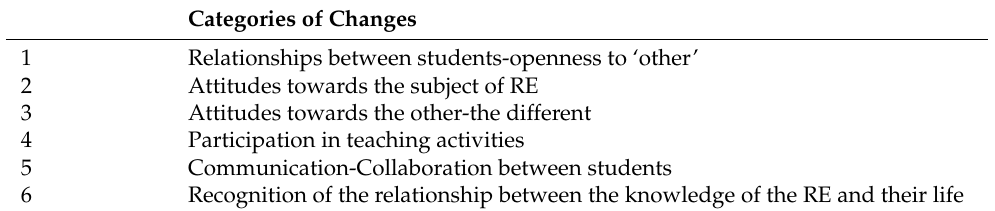
Table 11. Categories of changes observed in students by teachers during the school year (listed in order, depending on the number of entries in a total of 26 Gymnasium’s and 24 Lyceum’s